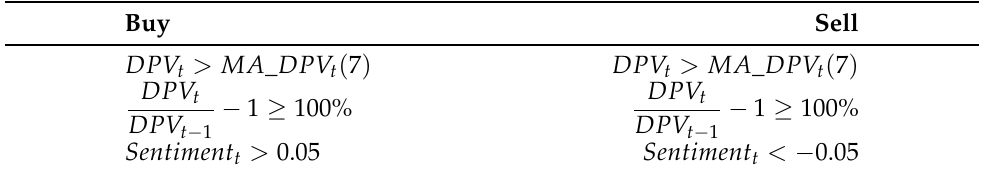
Table 5. Timing component for both TI-SiSS and SiSS . DPV t is the value of Popularity at time t ; MA _ DPV t ( 7 ) denotes the sample mean of the Popularity over the interval [ t − 6, t ] .